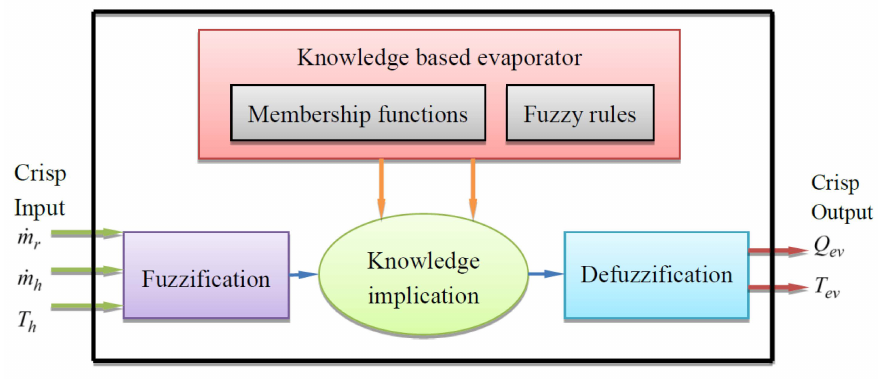
Figure 13. Fuzzy based evaporator model.